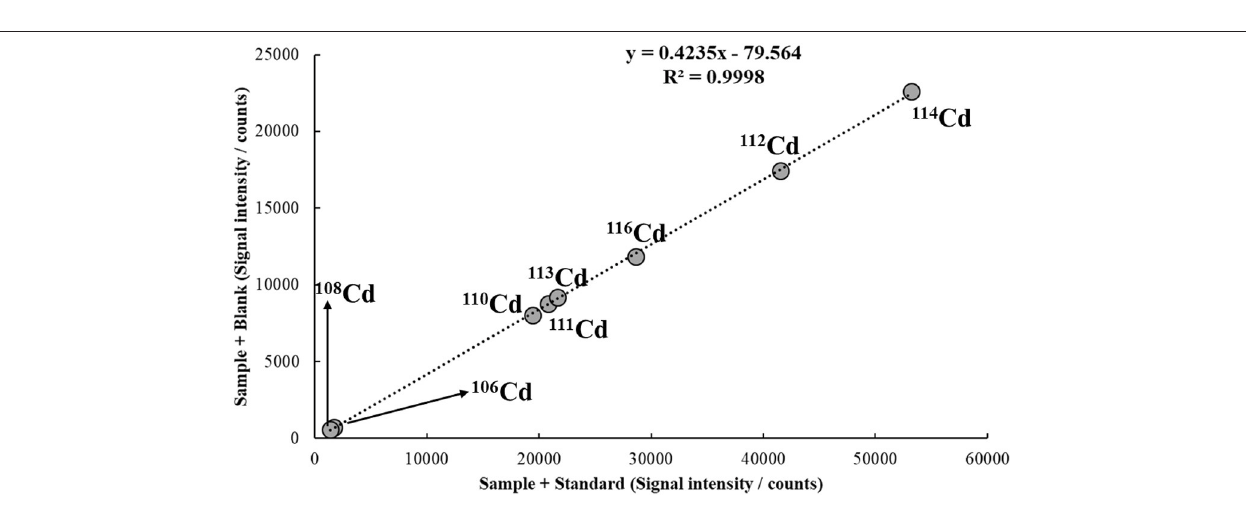
Note that if V Std = V Sam , i.e., a 1:1 mixture is used in S1 and S2, Equation (13) simplifies to Equation